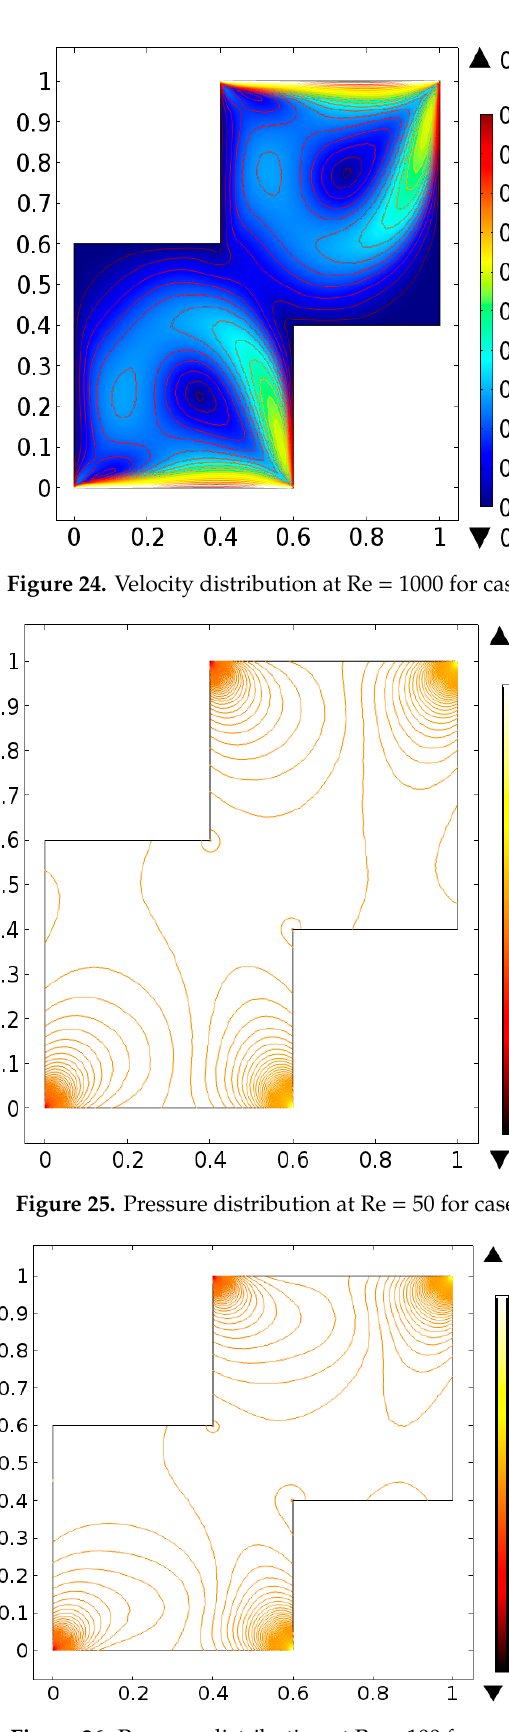
Figure 26. Pressure distribution at Re = 100 for case-II.